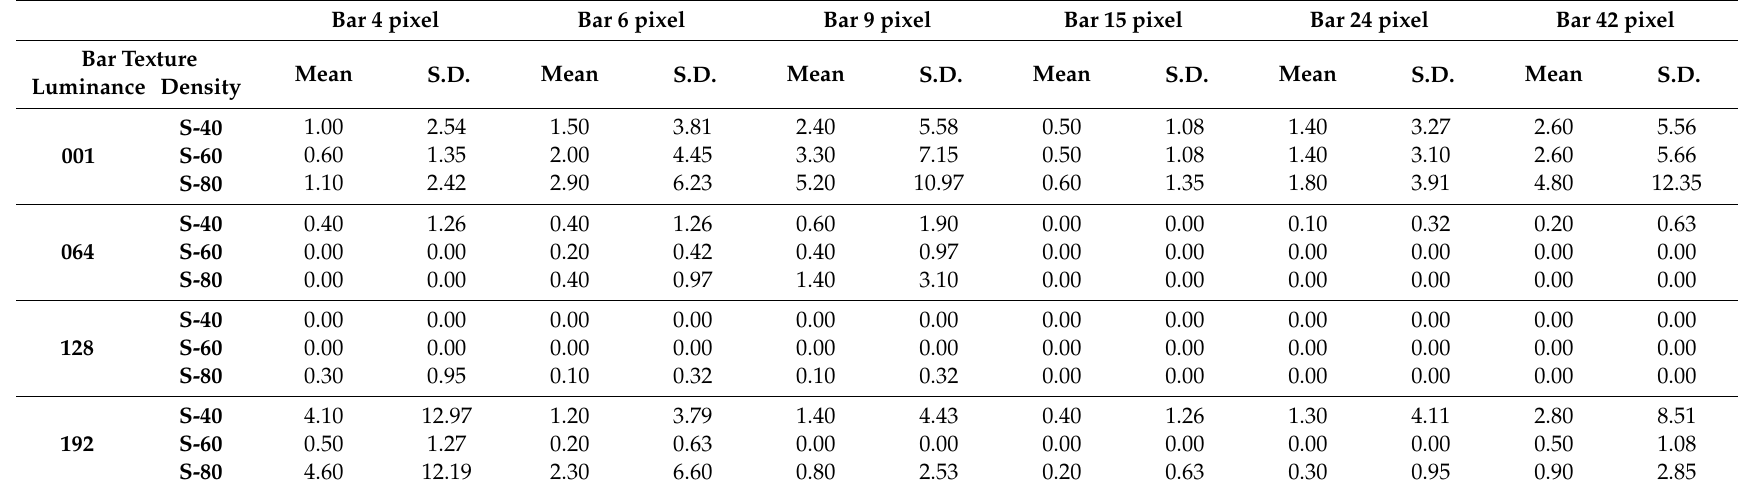
Table 5. Results of the second group of tests: textured Bar on uniform Background, Bar “Small” Texture manipulation (Luminance and